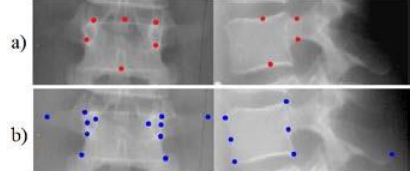
Figure 1. (a) Stereo corresponding points, (b) Non stereo corresponding points (A. Mitulescu et al, 2002) Point-based methods are considerably dependent on the skill of the expert operator for identifying exact points. Therefore, they have low reproducibility. These methods need time of about 2- 4 hours for reconstruction because of the manual identification.